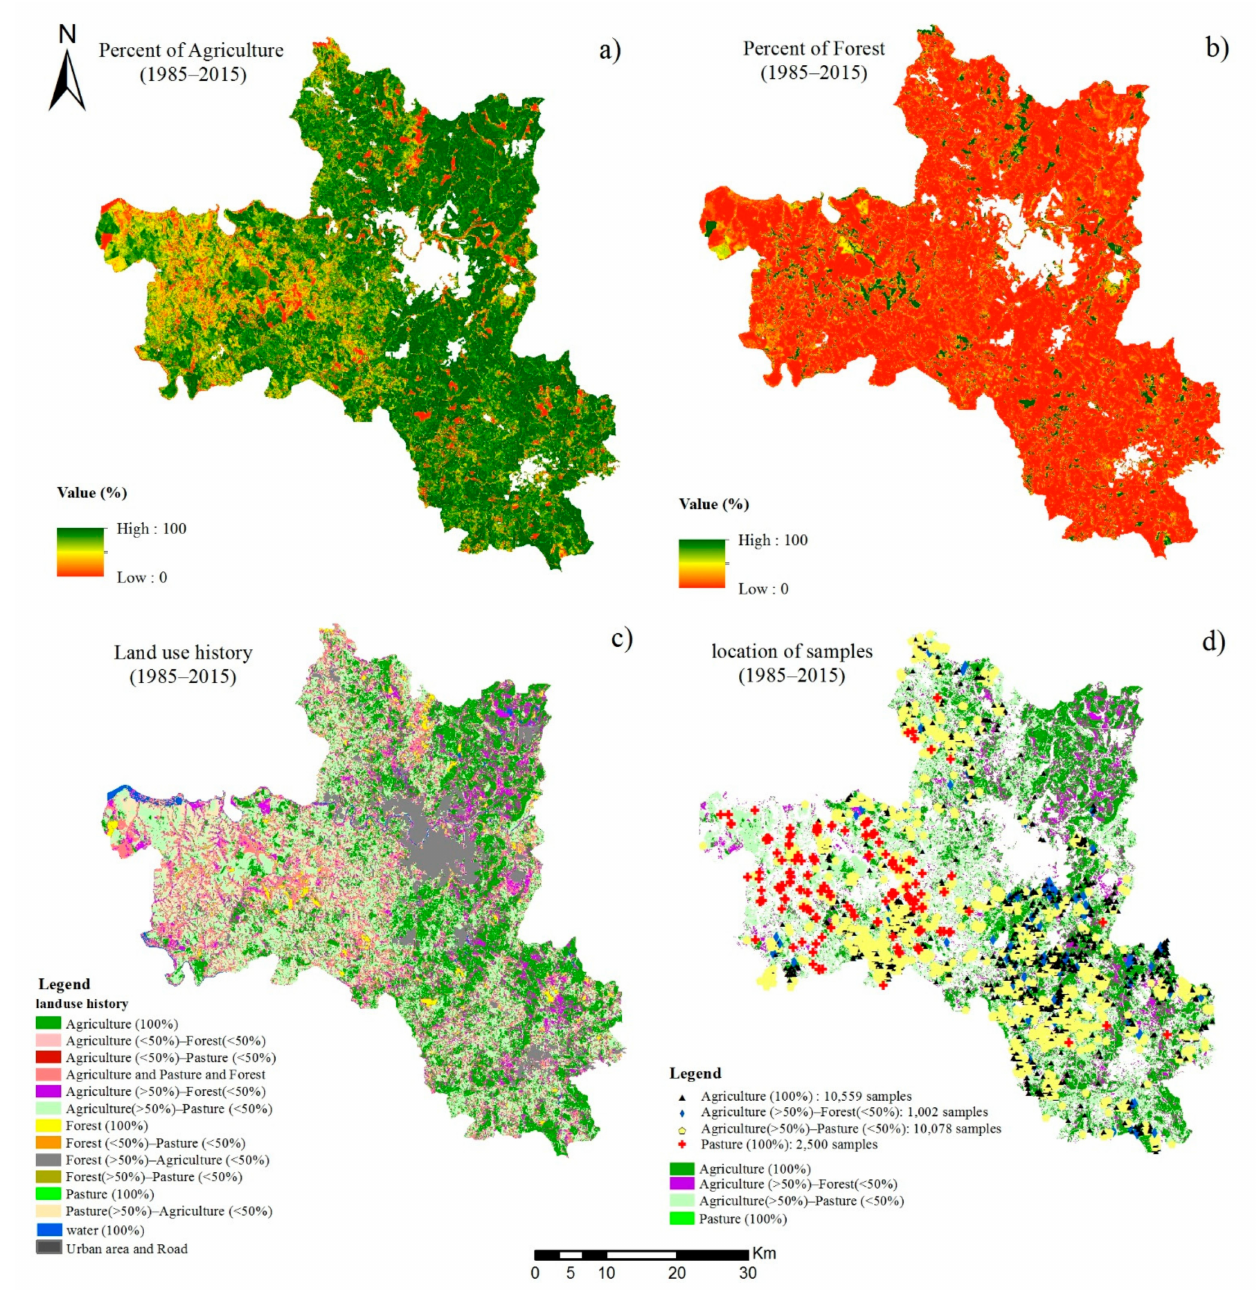
Figure 2. The frequency of alteration for agricultural use during 1985–2015 (higher percentage shows less changes in LULC during 1985–2015) ( a ); the frequency of alteration for forest use during 1985–2015 ( b ); LULC history map during 1985–2015 ( c ); the location of soil samples in each LULC history (the number of samples represent the whole sample along depth) for Piracicaba region ( d